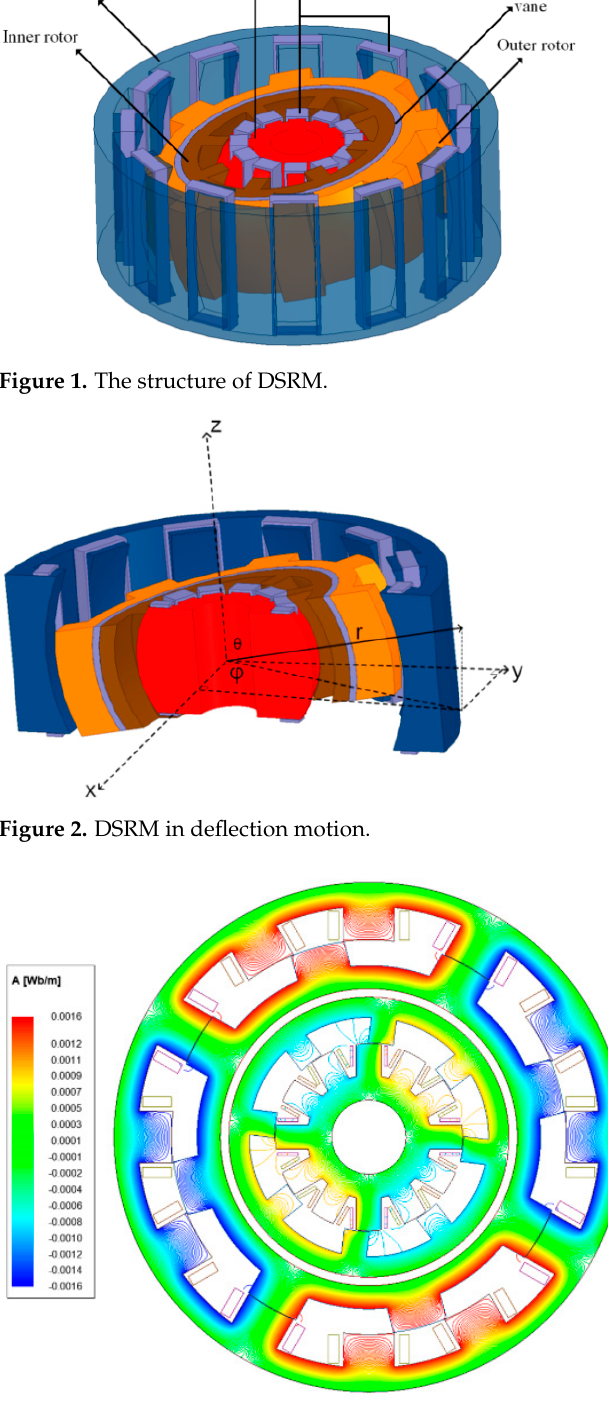
Figure 3. 2D magnetic-field-line distribution of DSRM.